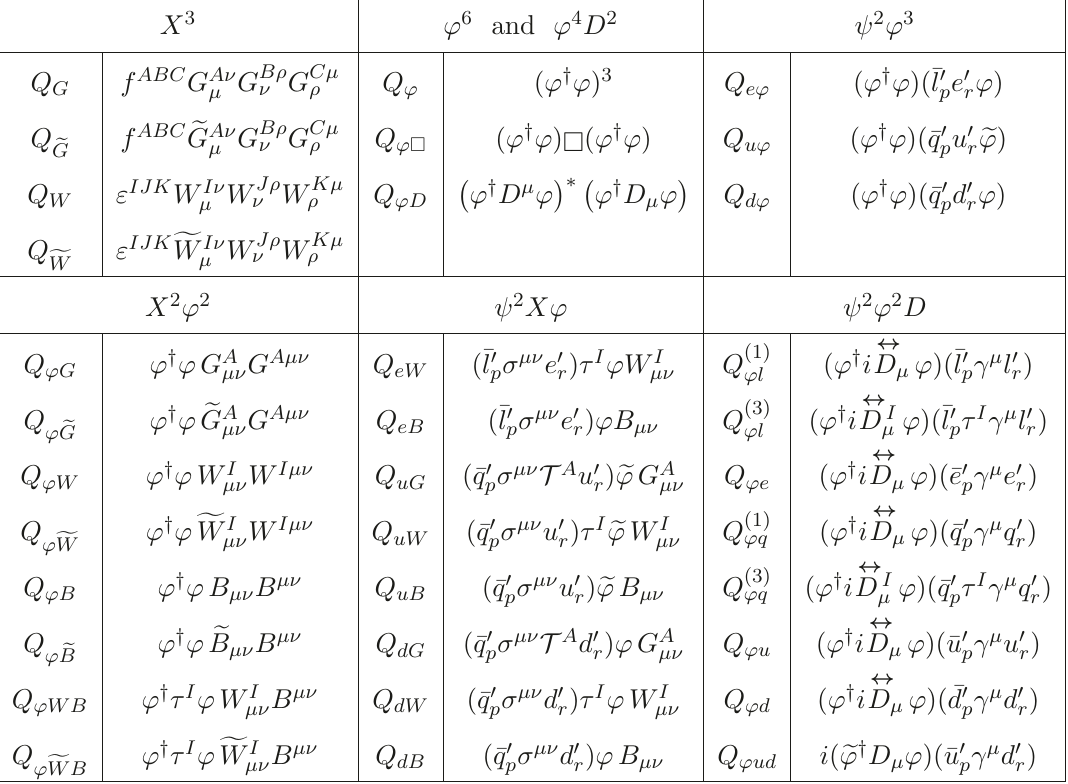
Table 2 . Dimension-6 operators other than the four-fermion ones (from ref. [11]). For brevity we suppress fermion chiral indices L, R